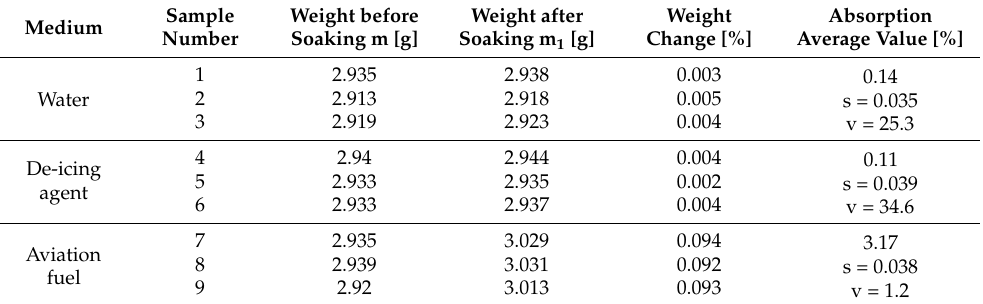
Table 11. Summary of plastic resistance test results after 14 days of soaking in